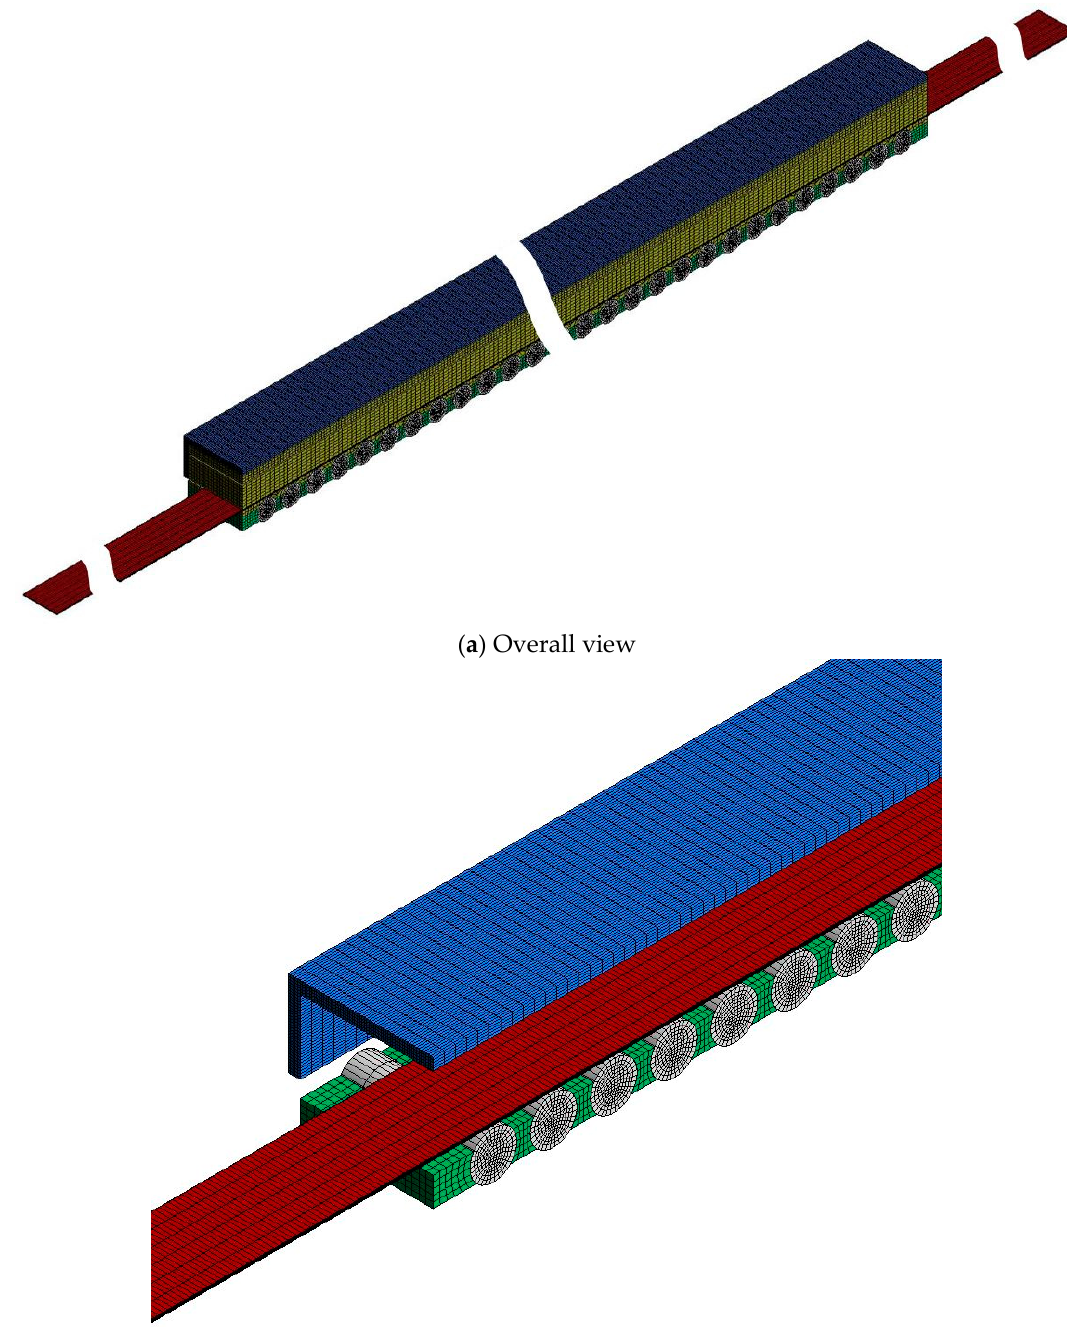
Figure 5. Computational grid systems of the traditional passive heat retention panel.